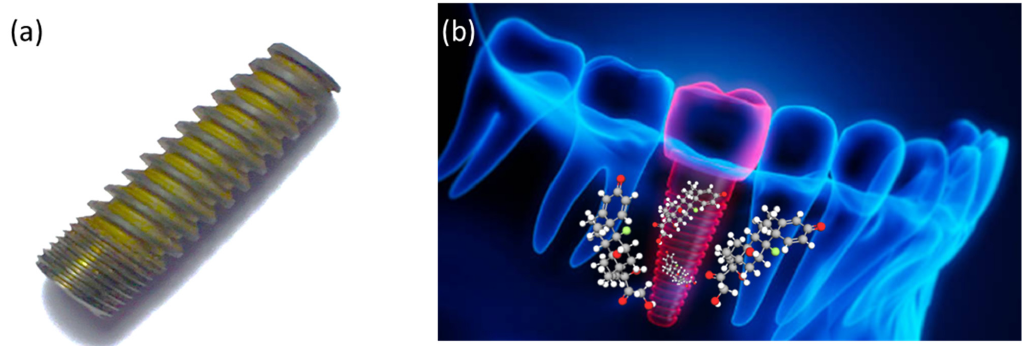
Figure 6. ( a ) DEX ‐ coated Ti dental implant developed by Dr. M. S. Bathaei research group, and ( b ) schematic representation of DEX release in implantation site. ( b ) schematic representation of DEX release in implantation